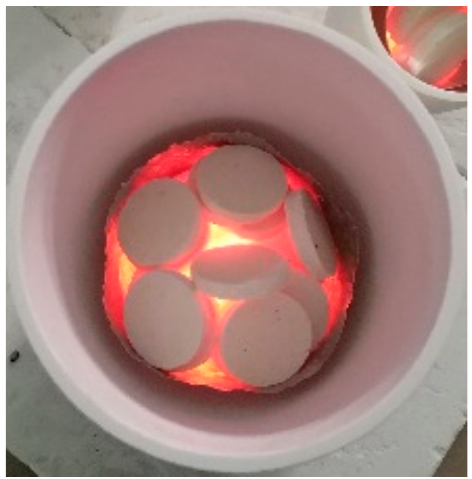
Figure 1. Calcined sample.